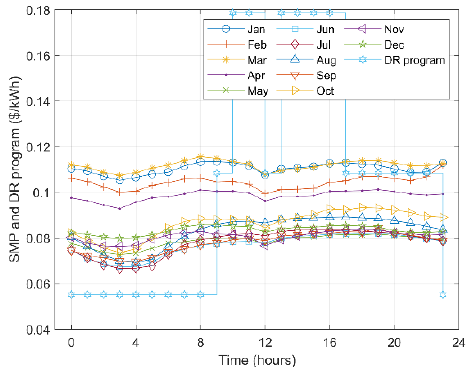
Figure 3. Electricity cost depending on average monthly SMP and DR program.